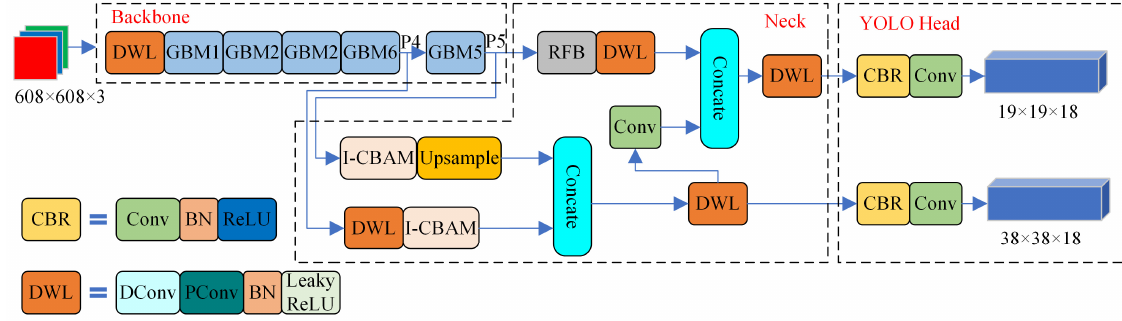
Figure 1. The structure of PMD-YOLO.